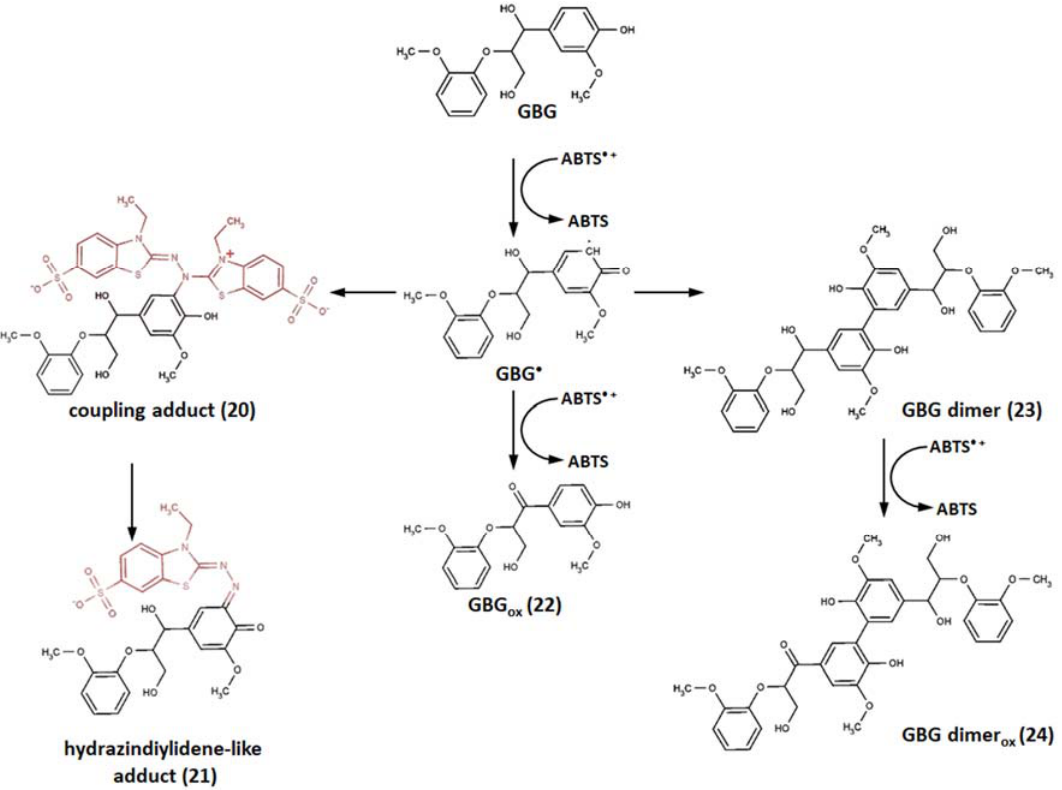
Figure10. ReactionpathwaysofABTS • + withguaiacylglycerol- β -guaiacylether(GBG)[130]. Copyright Figure 10. Reaction pathways of ABTS •+ with guaiacylglycerol ‐β‐ guaiacyl ether (GBG) [130]. 2018, adopted with permission from American Chemical Copyright 2018, adopted with permission from American Chemical Society.